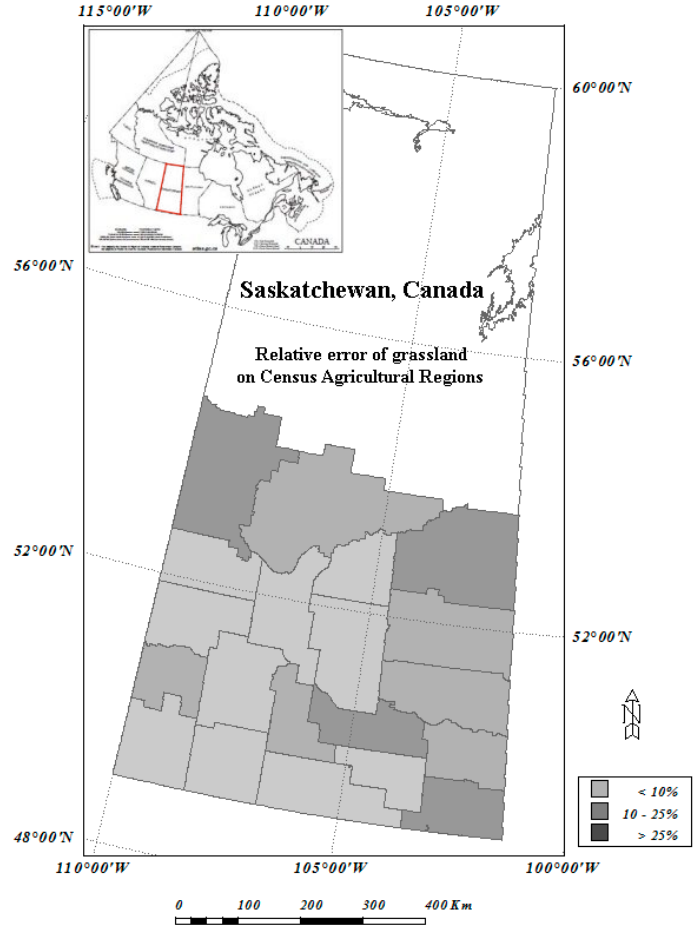
Figure 9. Relative error of grassland over CARs: Comparison between RF/MODIS result with the data of 2001 Census of Agriculture.